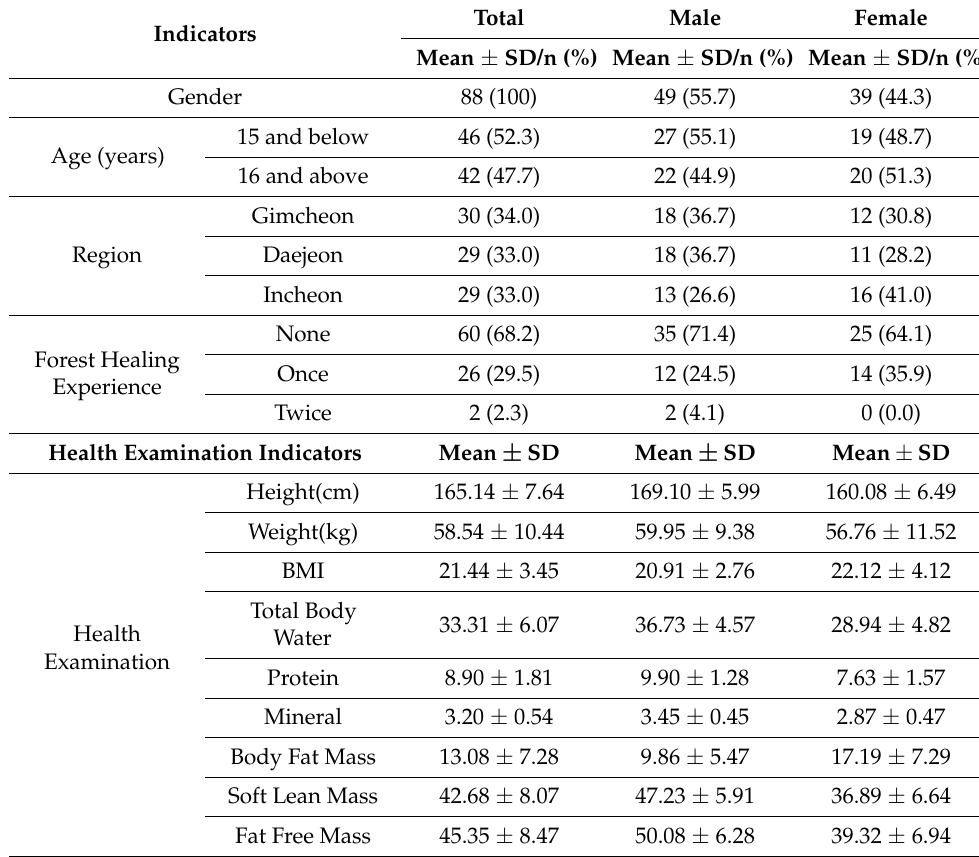
Table 1. Demographic characteristics of the participants.